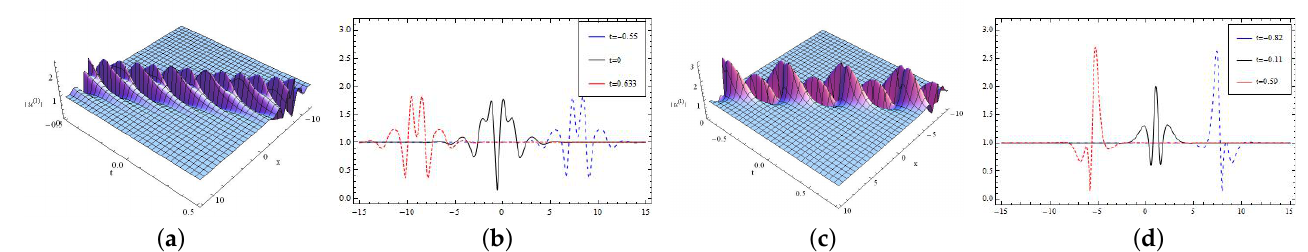
Figure 11. Plots of breather solutions of Equation (5): ( a , b ) double-peak breather solution of the focusing case with (cid:101) = 1, a = − 1, b = 1 ; ( c , d ) bright-bright breather solution of the defocusing case 5 with (cid:101) = 1, a = 1, b = 1 5